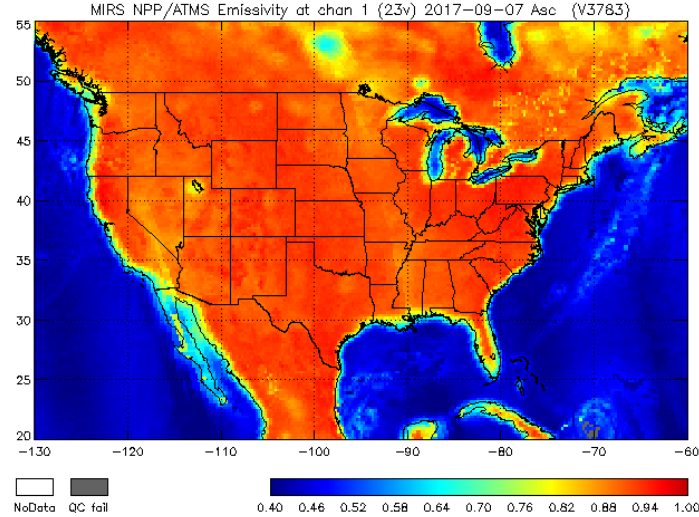
Figure 3. MiRS-based emissivity retrieved using SNPP/ATMS data from 7 September 2017. The emissivity of channel 1 (23 GHz) is shown. The emissivity is behaving as expected, with low values over the ocean, higher values over land, and intermediate values over coastal areas. Over land, lower values are also retrieved over water bodies and rivers. All cases have converged during the retrieval (not shown).